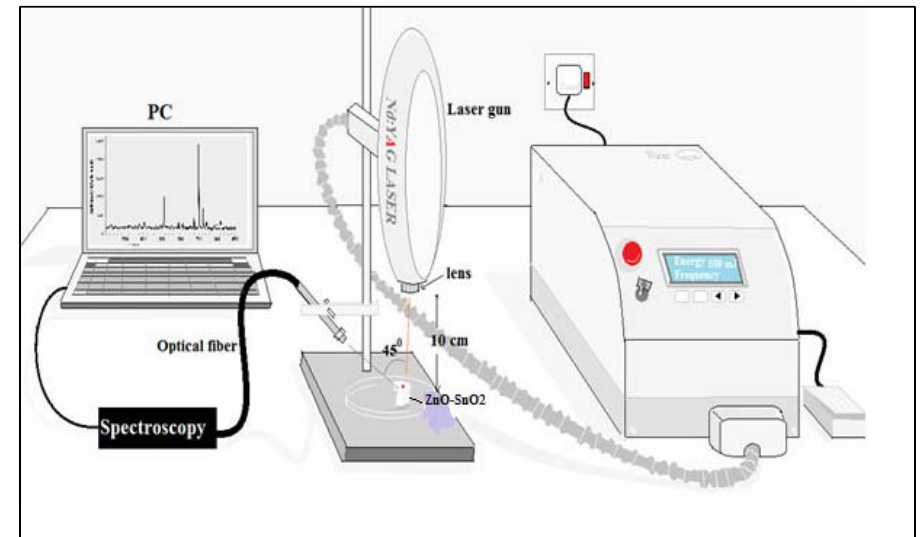
Fig.1: Configure the traditional LIBS system used in this